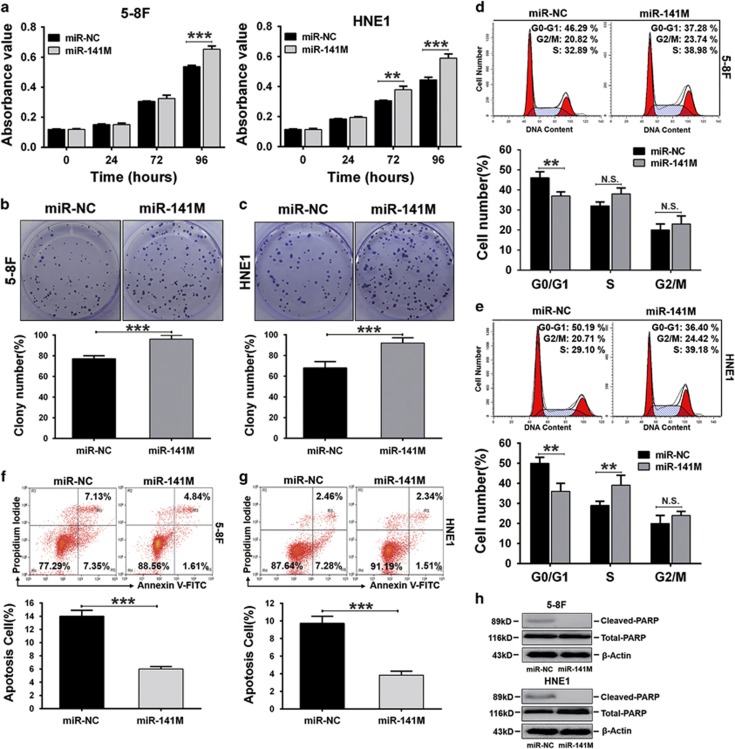
miR-141 promoted cell proliferation and inhibited apoptosis of 5-8F and HNE1 cell lines. (a) MTT assays of cells transfected with miR-141 mimic (miR-141M) or negative control (miR-NC). (b and c) Colony-forming assay images (upper panel) and quantification of colony number/well (lower panel). (d and e) Cell-cycle analysis by flow cytometry. (f and g) Annexin V-FITC and PI double staining analysis of cell apoptosis by flow cytometry. (h) Expression of the apoptosis marker cleaved-PARP (c-PARP) was determined by western blot. β-Actin served as an internal control. (a–g) The error bars are presented as the mean±S.E.M. **P<0.01, ***P<0.001, NS, no significance. All experiments were performed in triplicate